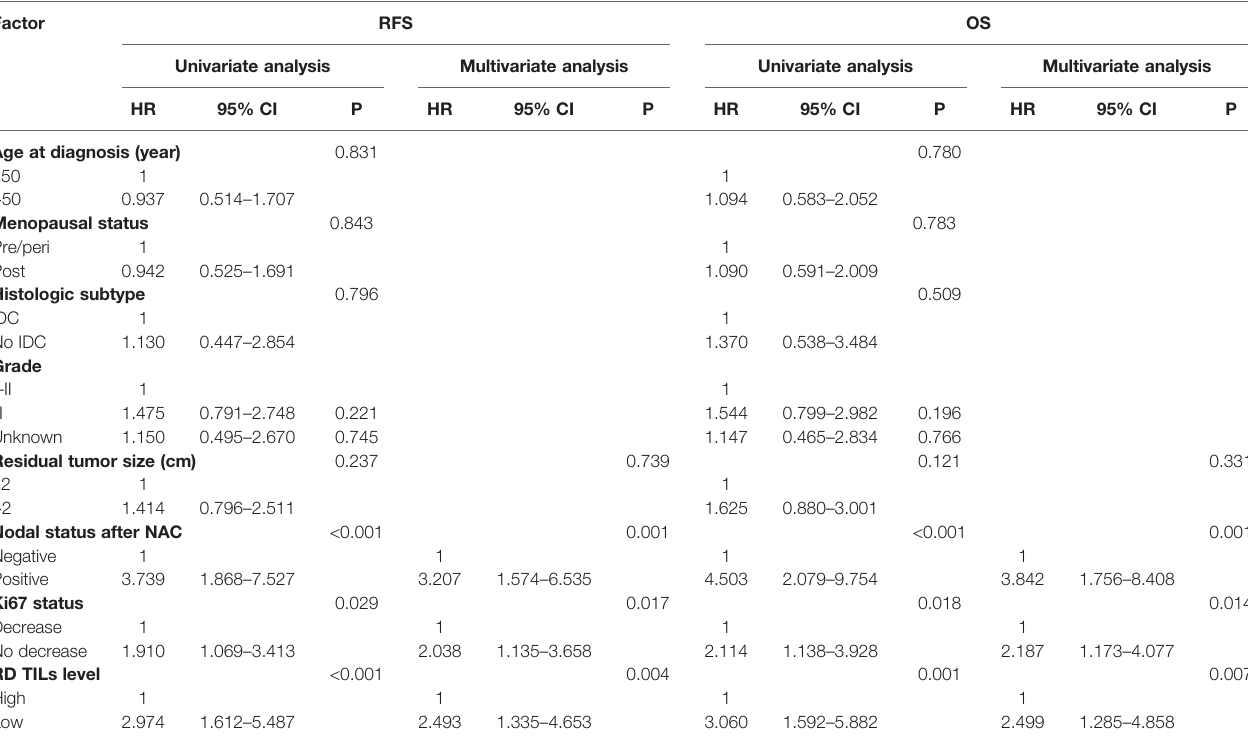
TABLE 4 | Univariate and multivariate analyses for RFS and OS in all TNBC patients.